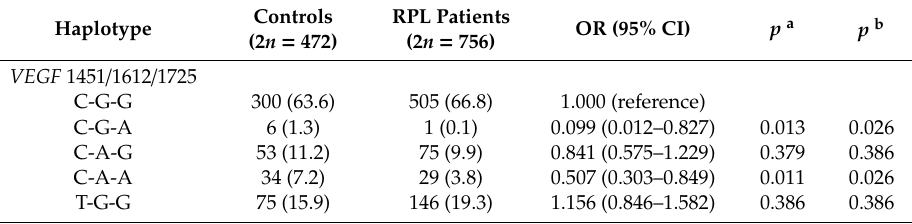
Table 3. Haplotype analysis for the VEGF polymorphisms 1451C > T, 1612G > A and 1725G > A in RPL patients and